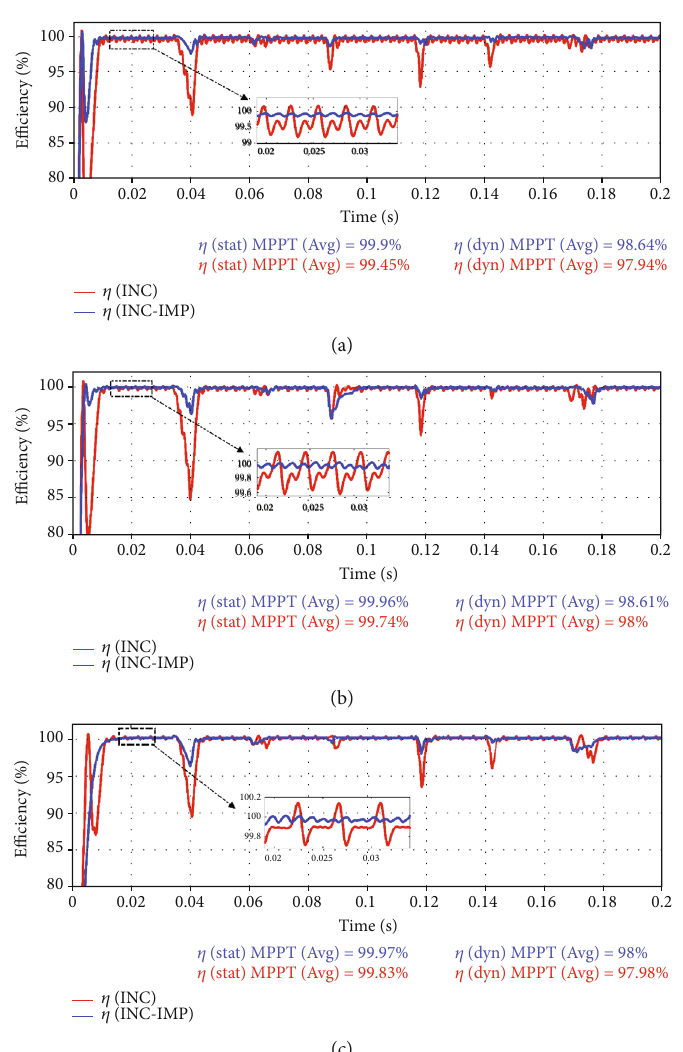
Figure 24: E ffi ciency pro fi le comparison between the conventional INC and improved INC MPPT methods under the scenario of temperature variation with normal solar radiation (a) 1000 W/m 2 , (b) 800W/m 2 , and (c) 600 W/m 2